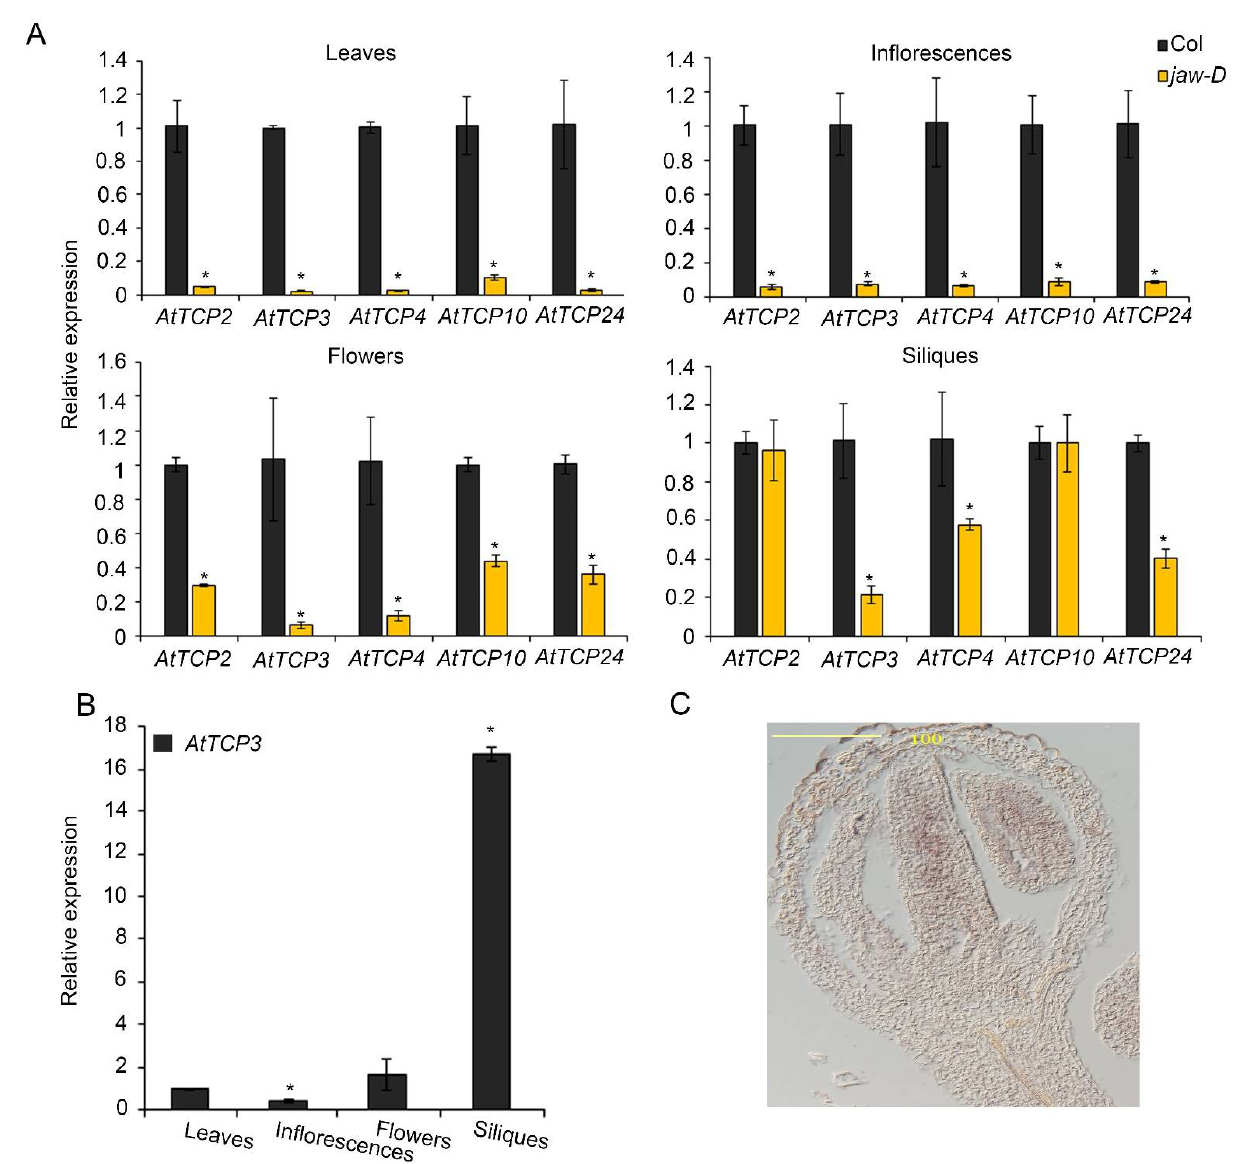
Figure 2. Expression patterns of miR319a-targeted TCP genes. ( A ) The relative expression level of AtTCP genes in the jaw-D mutant cauline leaves, inflorescences, flowers (stage 14–15), and siliques (stage 17) as compared to wild type plants (Col). ( B ) Real-time PCR showing the relative expression levels of AtTCP3 in cauline leaves, flower buds, flowers, and siliques (stage 17) in wild-type plants (Col). ( C ) In situ hybridization of AtTCP3 in transverse cross-section of Col siliques (stage 8). Three biological replicates are taken. Error bars indicate SE. * indicates p < 0.05 .